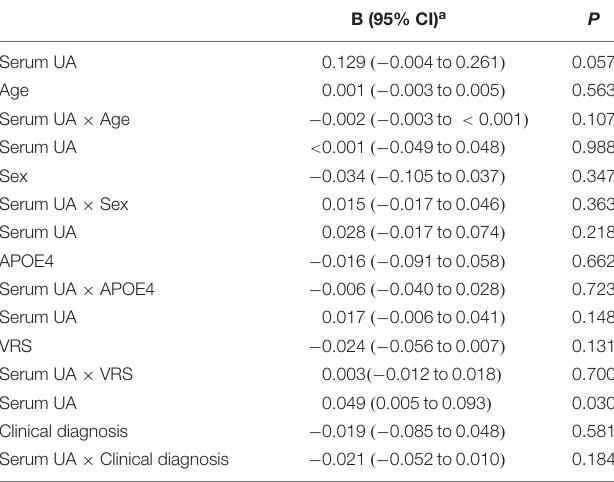
TABLE 5 | Results of multiple logistic regression and general linear model analyses for assessing the relationship between serum UA strata and A β , AV-1451, AD-CM, or WMH volume in cognitive normal older adults.